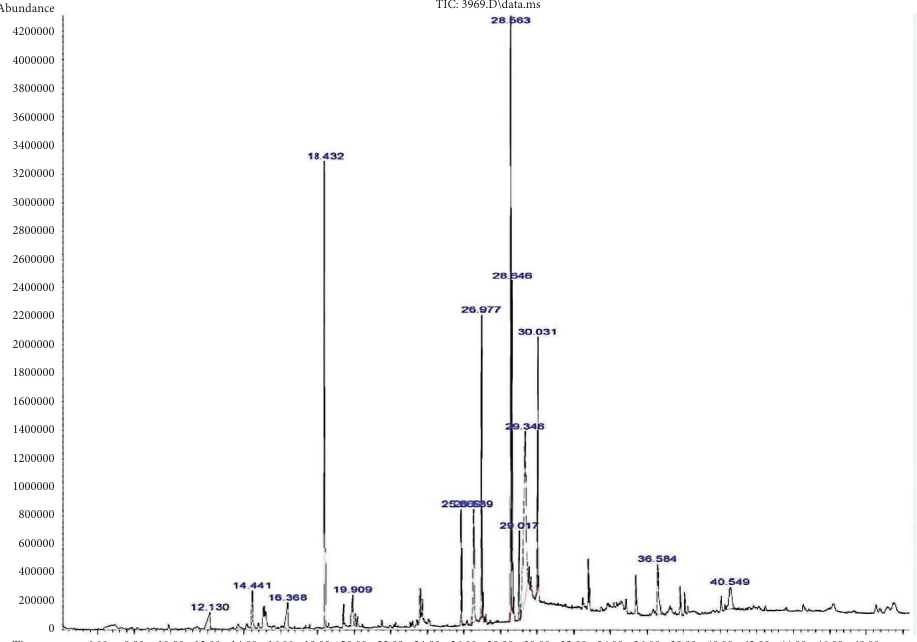
Figure 17: GC-MS analysis of the partially purifed biosurfactant produced by P. guguanensis strain Iraqi ZG.K.M. Methyl linoleate was the predominant fatty acid which gave a predominant peak at RT